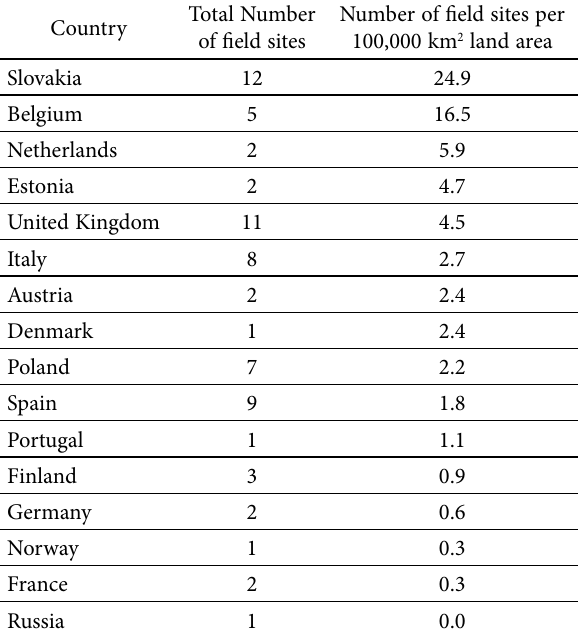
Table 3. Distribution of biochar field sites by countries in the COST Action. Countries are arranged by the number of field sites per 100,000 km 2 land area (not including water bodies). Countries without field sites are not listed (Feb.